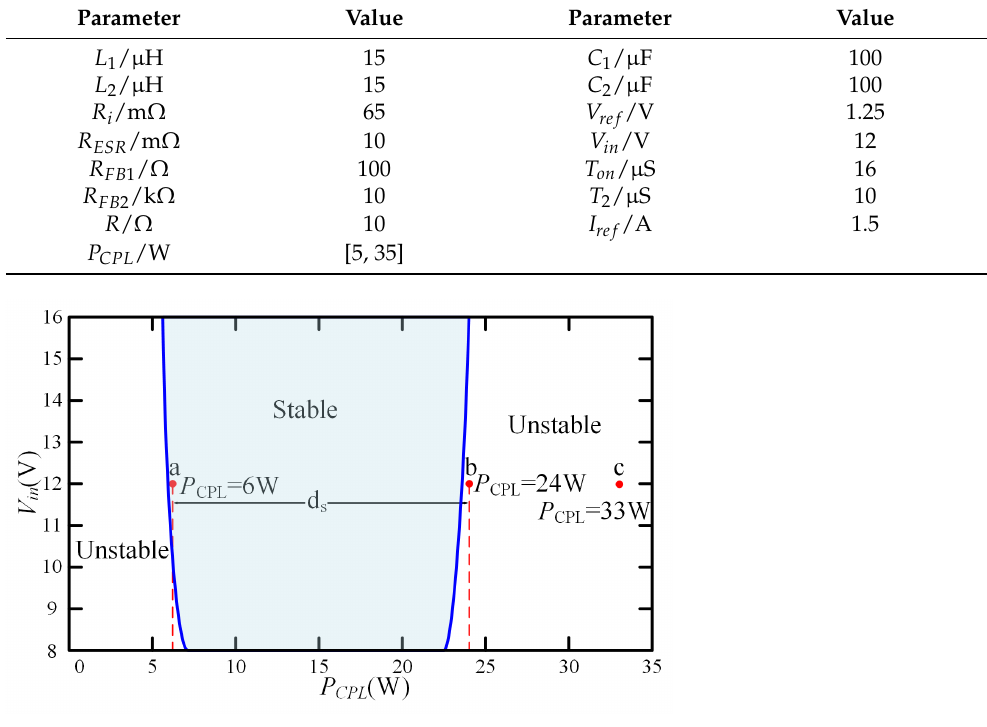
Figure 4. Stability boundary of the system as V in varies from 8 to 16 V and P CPL varies from 0 W to 35 W.